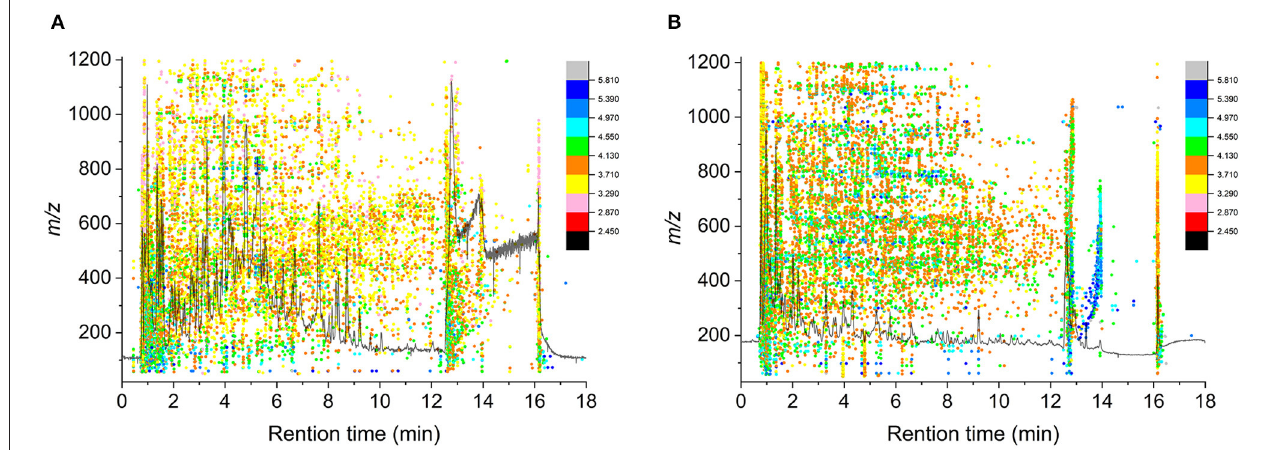
FIGURE 1 | Bubble plot of TIC and acquired data under positive (A) and negative (B) ion mode.